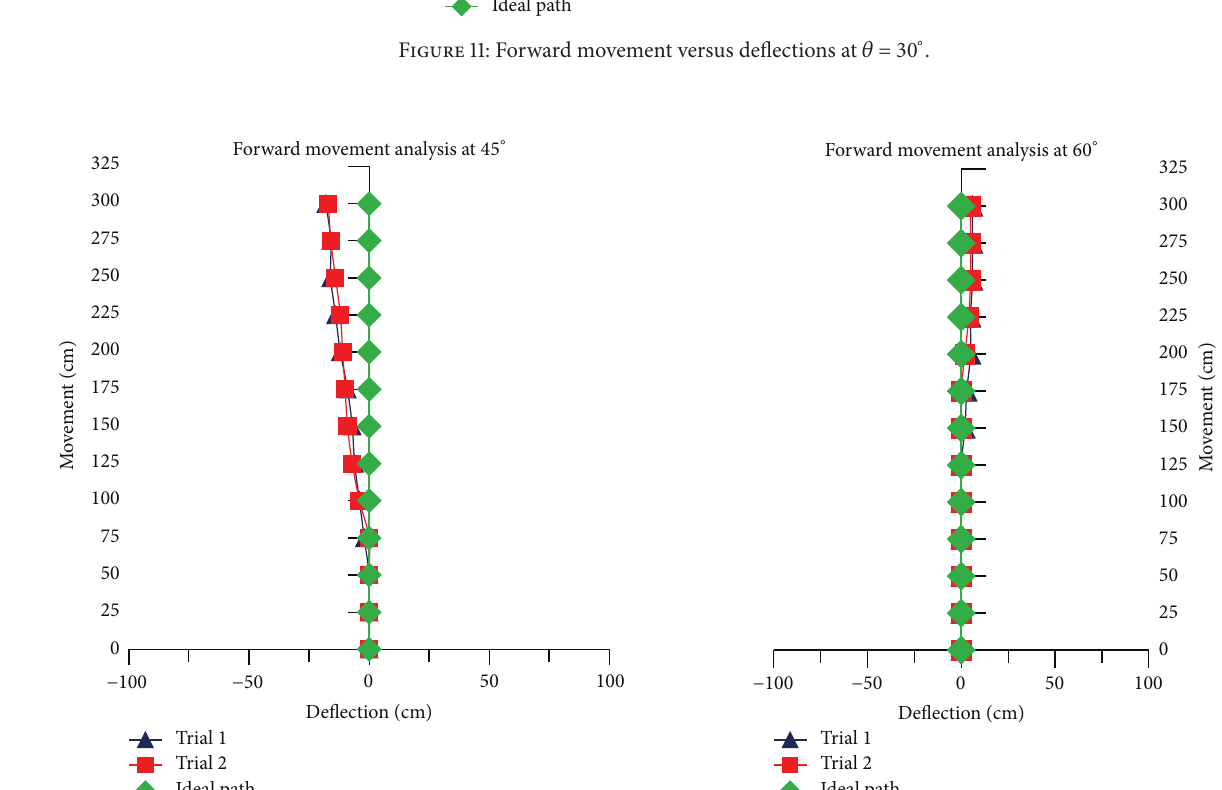
floor and several experimental results indicated that the omnidirectional mobile robot had a desirable full mobility and smooth motion.